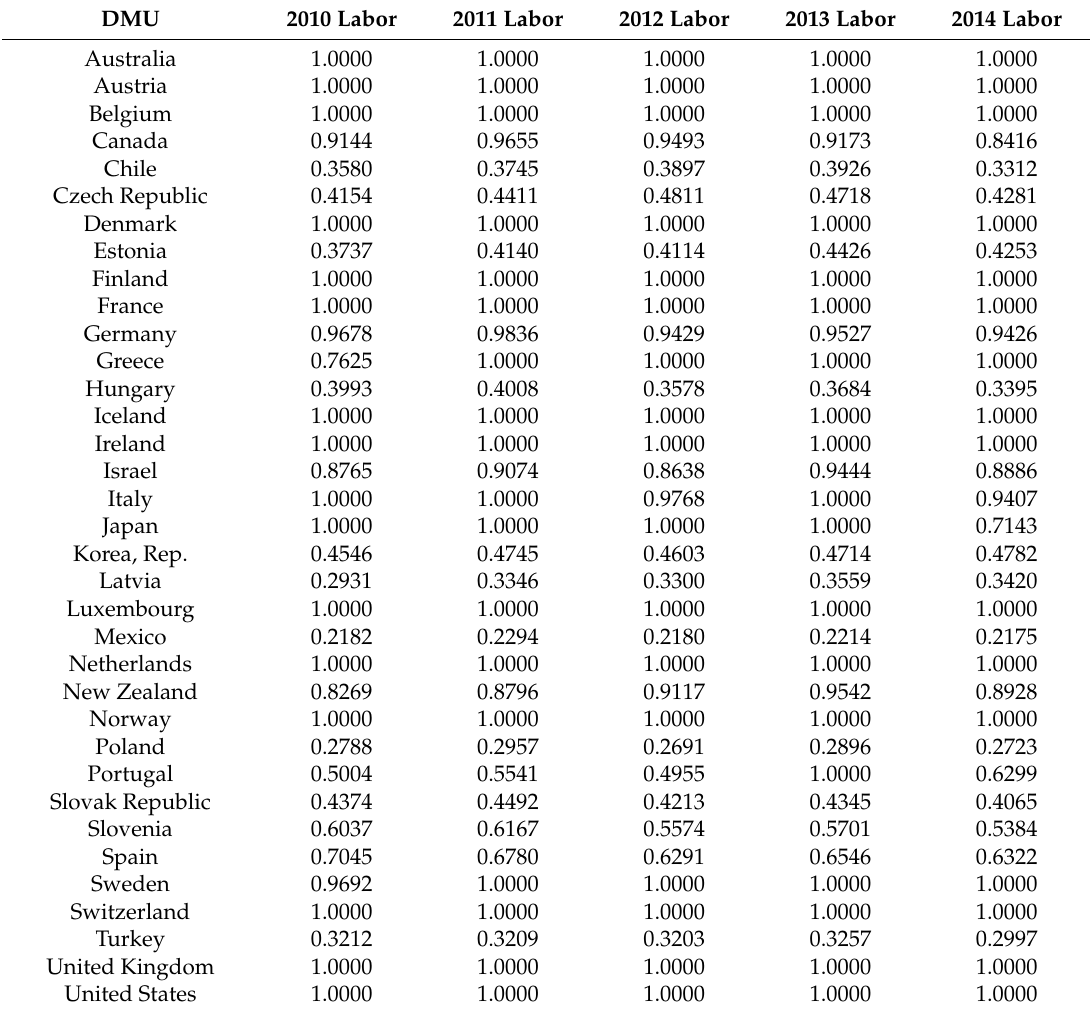
Table 3. Labor efficiency from